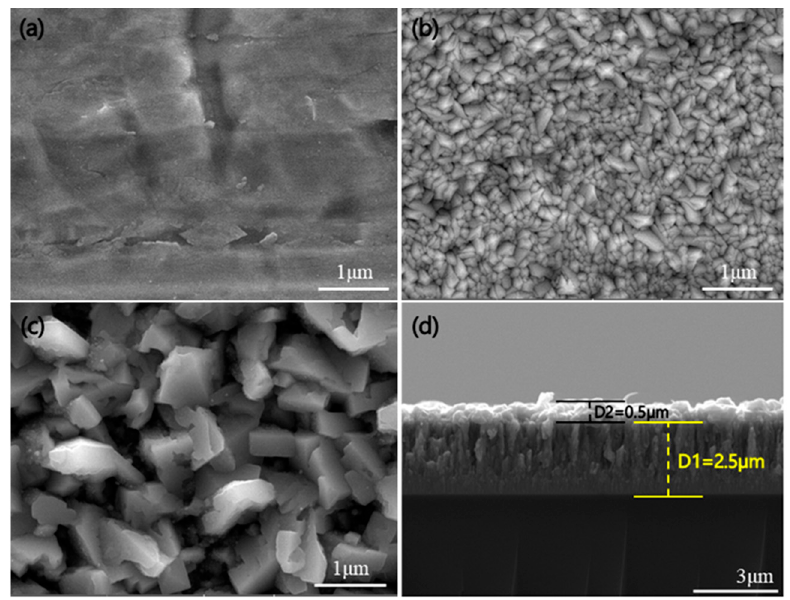
Figure 2. FE - SEM surface images of ( a ) Cu foil, ( b ) TiNi thin film, and ( c ) Sn thin film. ( d ) Cross- section of the Sn/TiNi thin film deposited on a glass substrate under the same growth conditions.